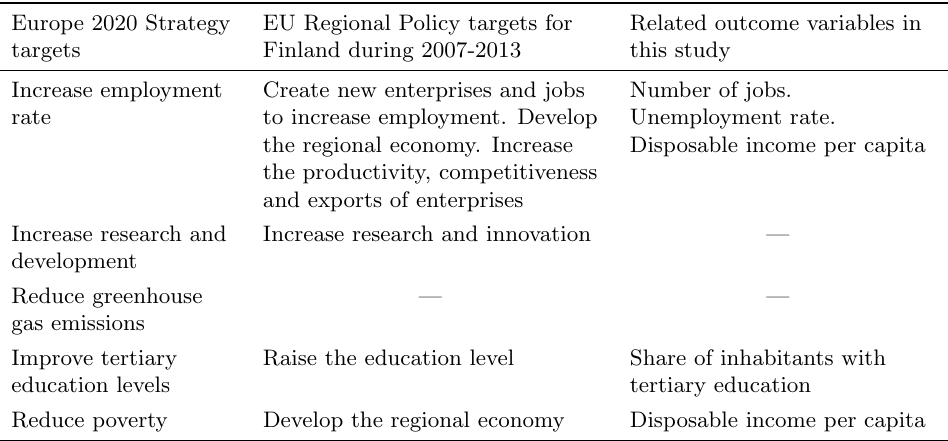
Table 3: Linkages between different policy targets and our outcome